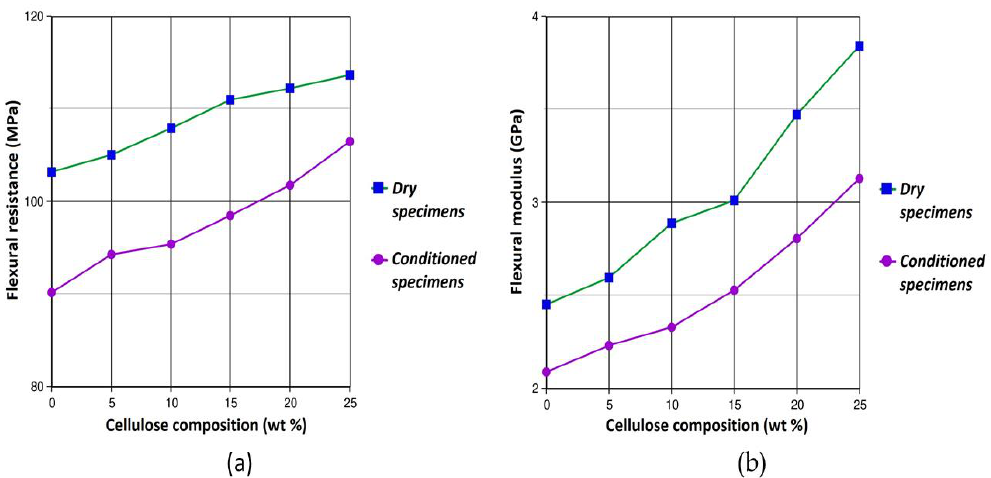
Figure 10. ( a ) Flexural resistance and ( b ) flexural modulus of elasticity (MOE) of the pulp cellulose composites.